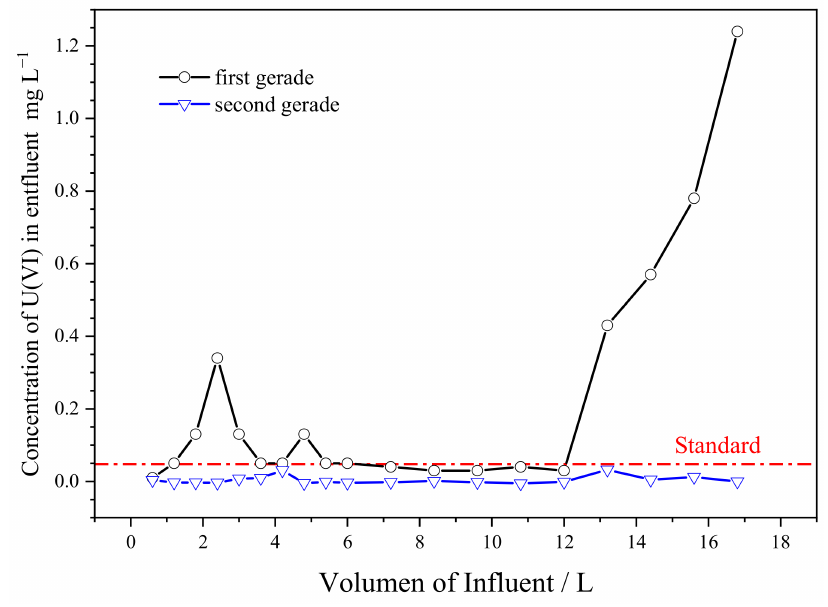
Figure 13. Two-grade serial effluent concentration curve.